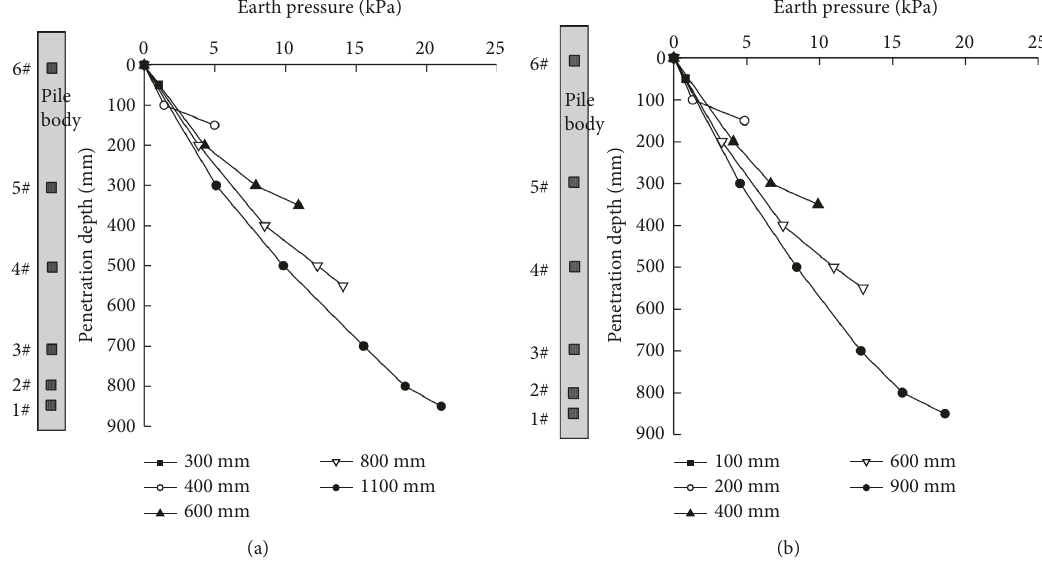
Figure 5: Distribution of earth pressure for test piles TP1 and TP2 during pile jacking: (a) TP1, (b) TP2.